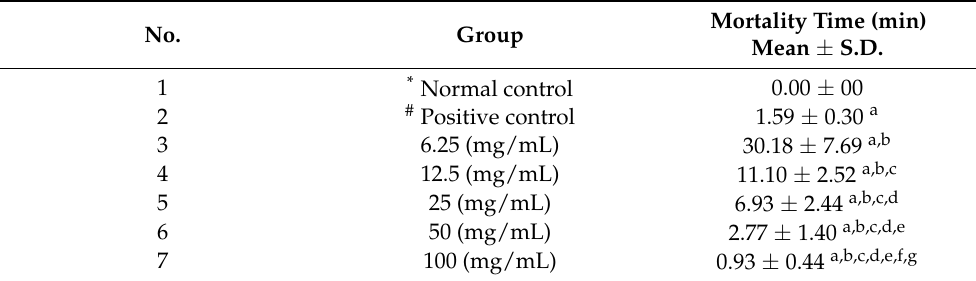
Table 1. Mortality time of the leeches at different concentrations of methanol extract of S. polycystum . Each value represents the mean ± S.D of 6 parasitic leeches per group.